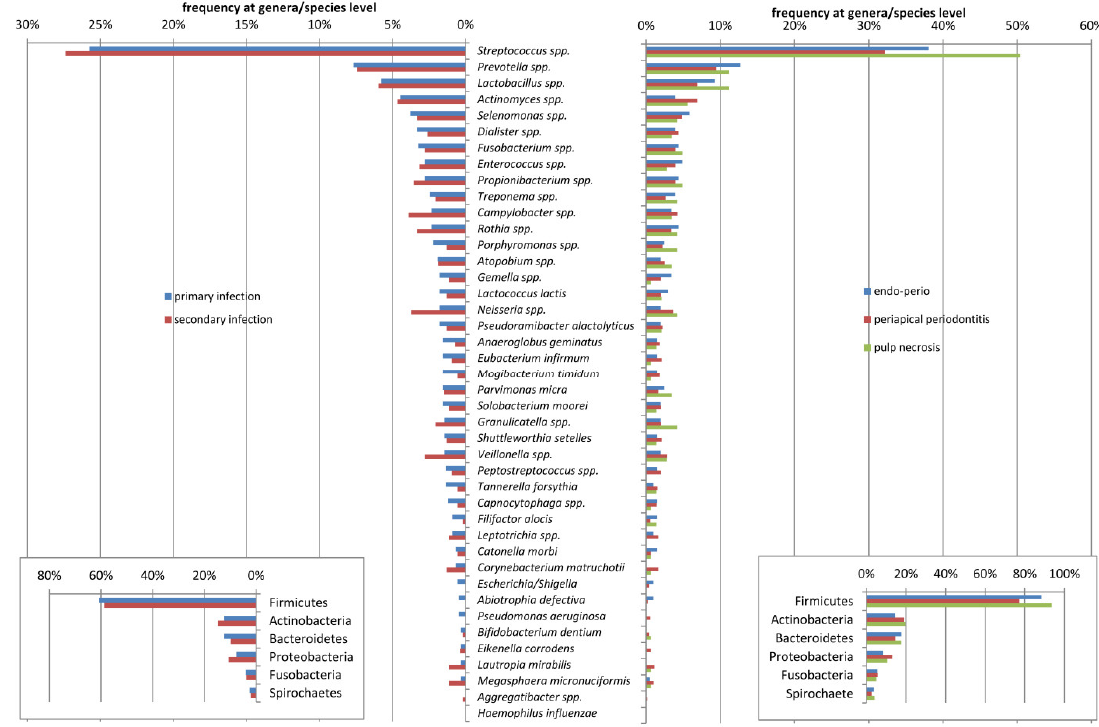
Figure 3. The distribution of microorganisms in the root canal samples from patients with primary and secondary endodontic infections and with different entities of apical periodontitis obtained by molecular methods. (Median,